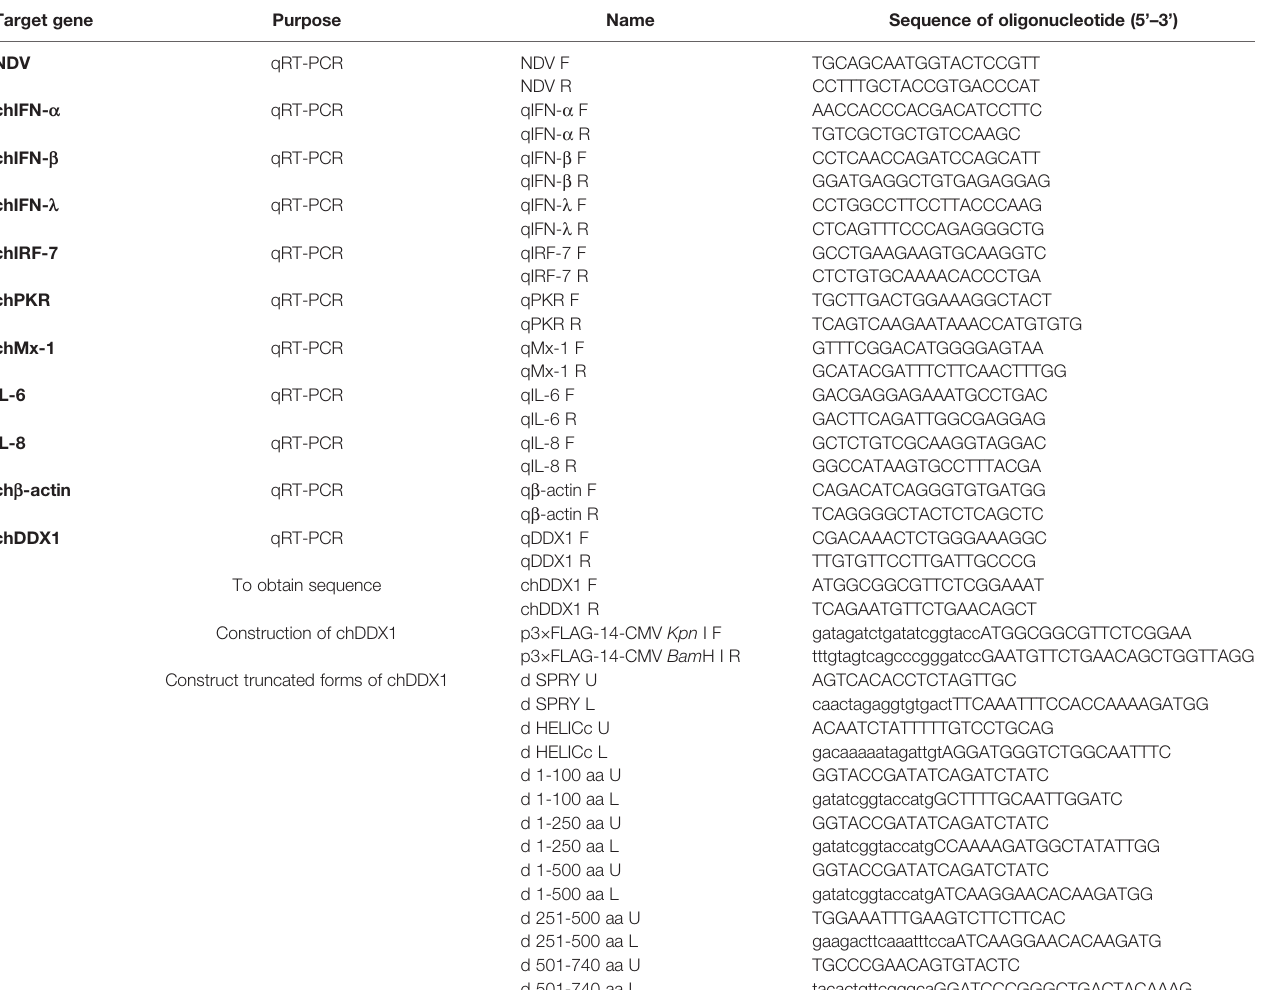
TABLE 1 | PCR primers used in the